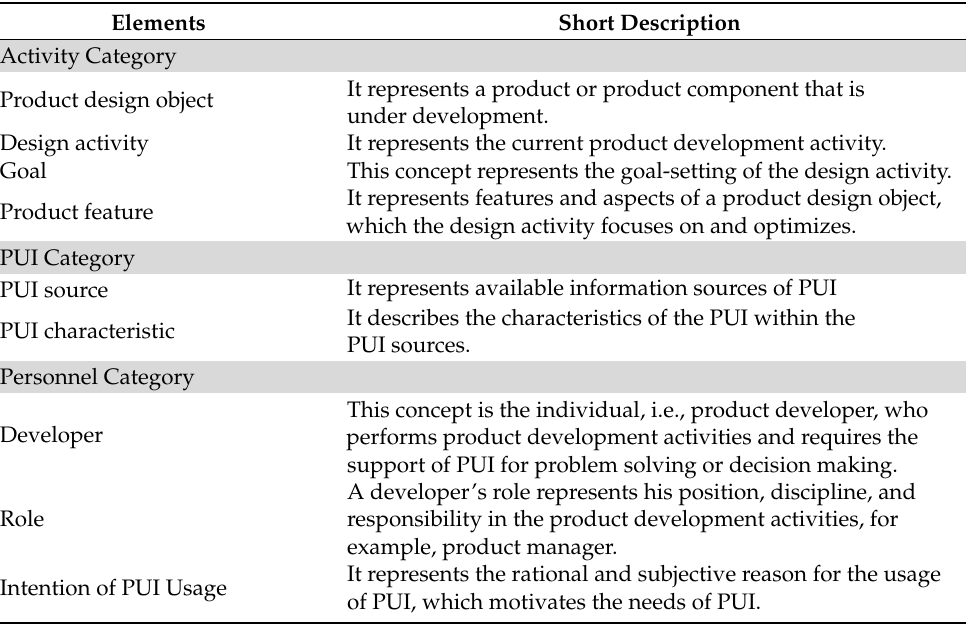
Table 2. Overview of key elements in the product development task